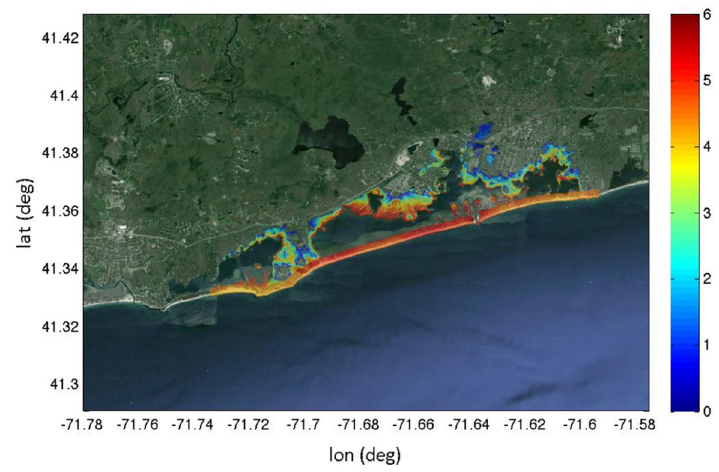
Figure 8. Total water depth (m) (inundation plus controlling wave height) for Charlestown, RI, 100 year event, dune eroded.